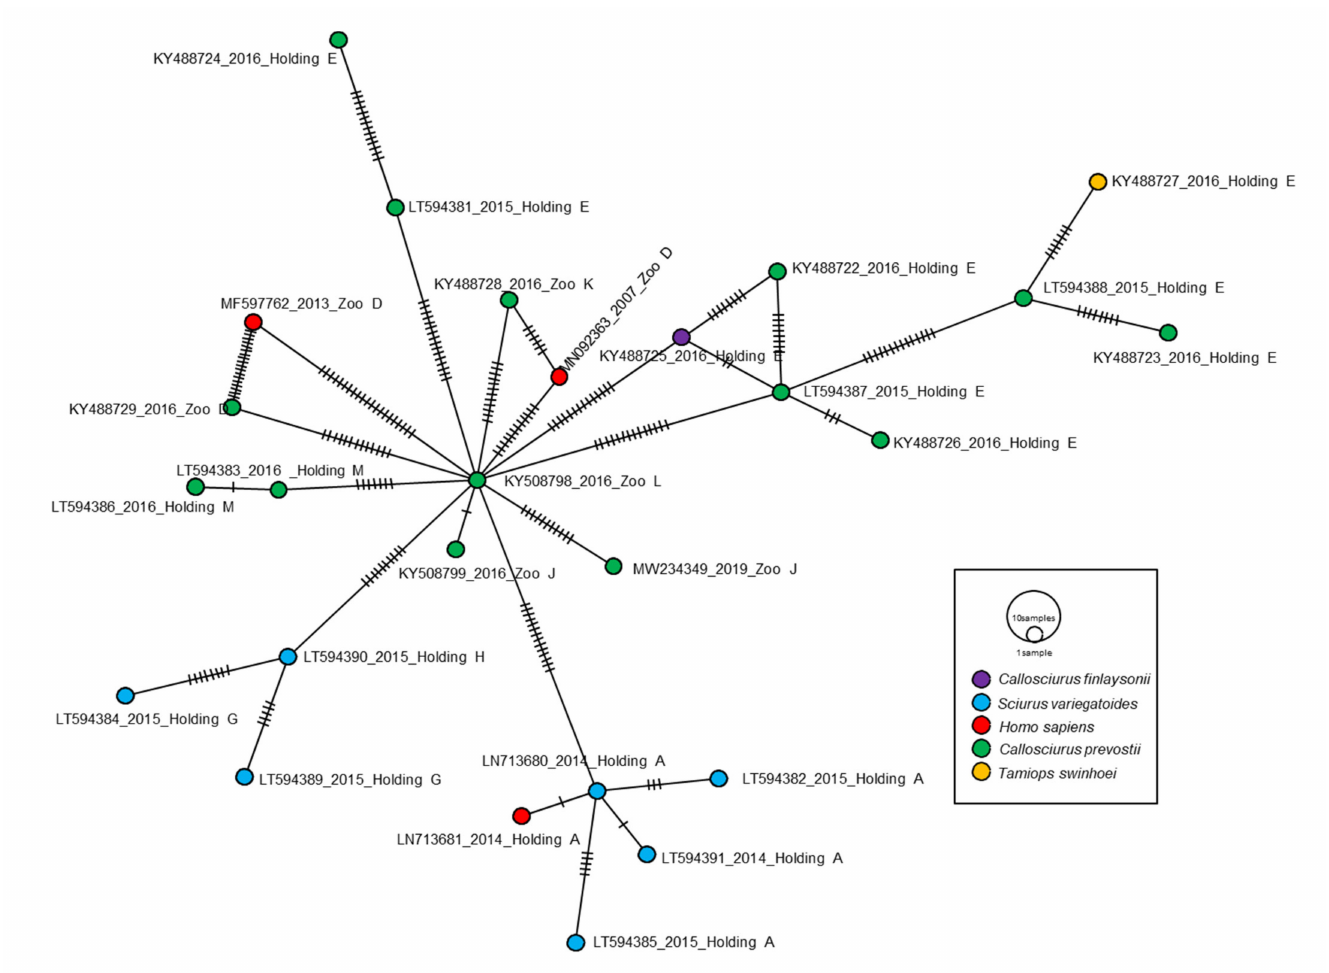
Figure 3. A minimum-spanning network constructed from a coding-complete genome alignment of different VSBV-1 strains. Each colored vertex represents a sampled viral haplotype, with different colors indicating the different hosts. The size of each vertex is relative to the number of sampled viral strains and the dashes on branches show the number of mutations between